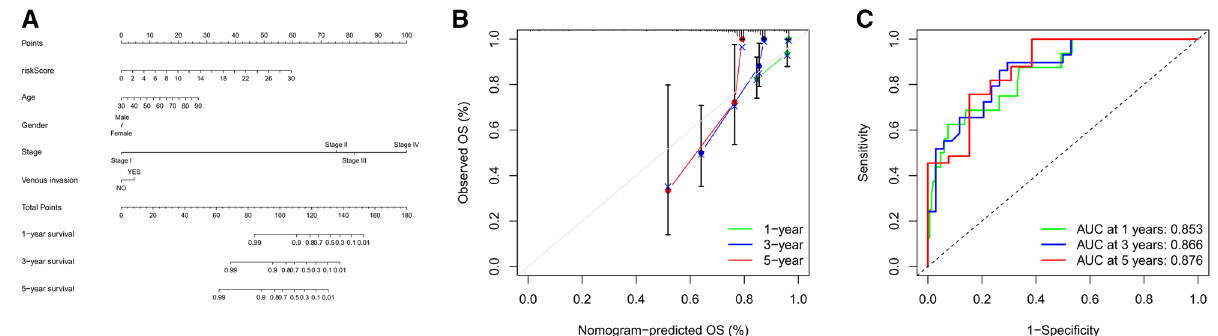
Figure 6. Construction of the prognostic nomogram. ( A ) Construction of the nomogram based on multivariate Cox regression models. ( B ) The 1-, 3-, and 5-years calibration plots for evaluating the agreement between the predicted and the actual prognosis for the prognostic signature. ( C ) The areas under the ROC curve about 1-, 3-, and 5-years of the